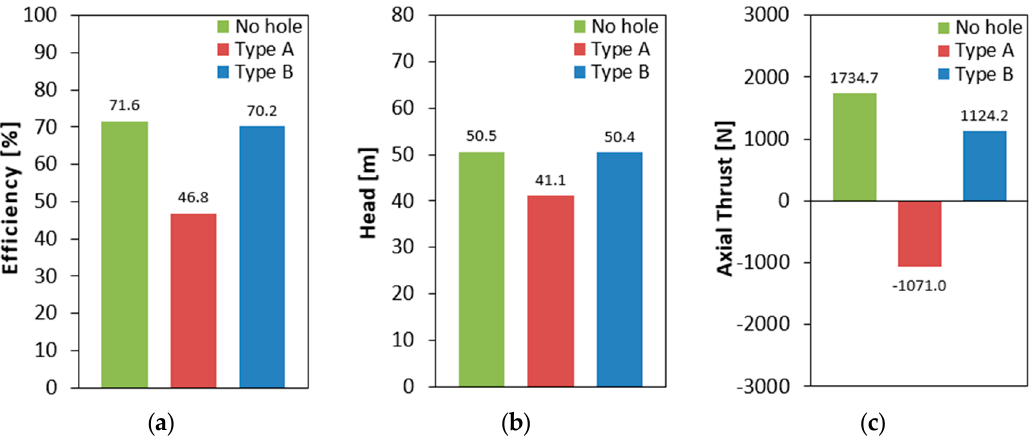
Figure 6. Comparison of the performance and axial thrust of the pump without balancing holes and pumps with six Type A and B balancing holes of 4 mm diameter.